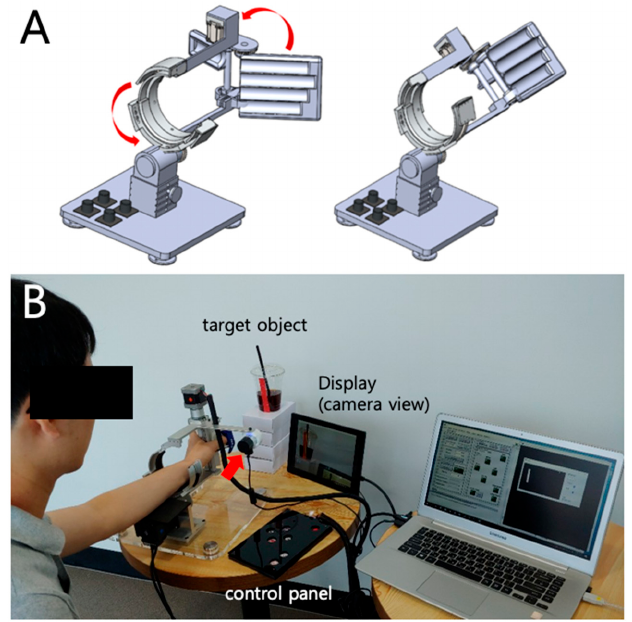
Figure 2. ( A ) Initial design for the two-axis distal upper limb rehabilitation robot is shown. ( B ) The developed system for this study is shown. The camera on the robot is indicated with red